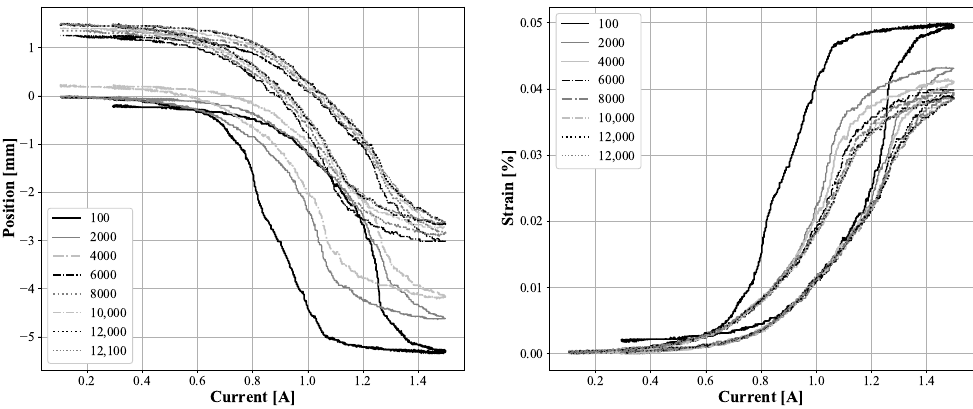
Figure 4. Degradation of the strain ( Right ) and the start/end position ( Left ) for the full